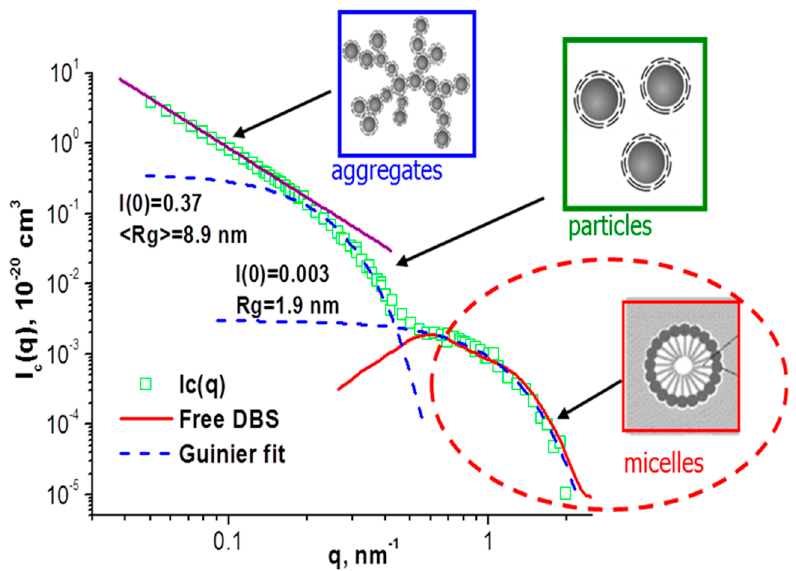
Figure 12. Complex structure of water-based ferrofluids with surfactant excess in its. Reprinted with permission from Reference [152].